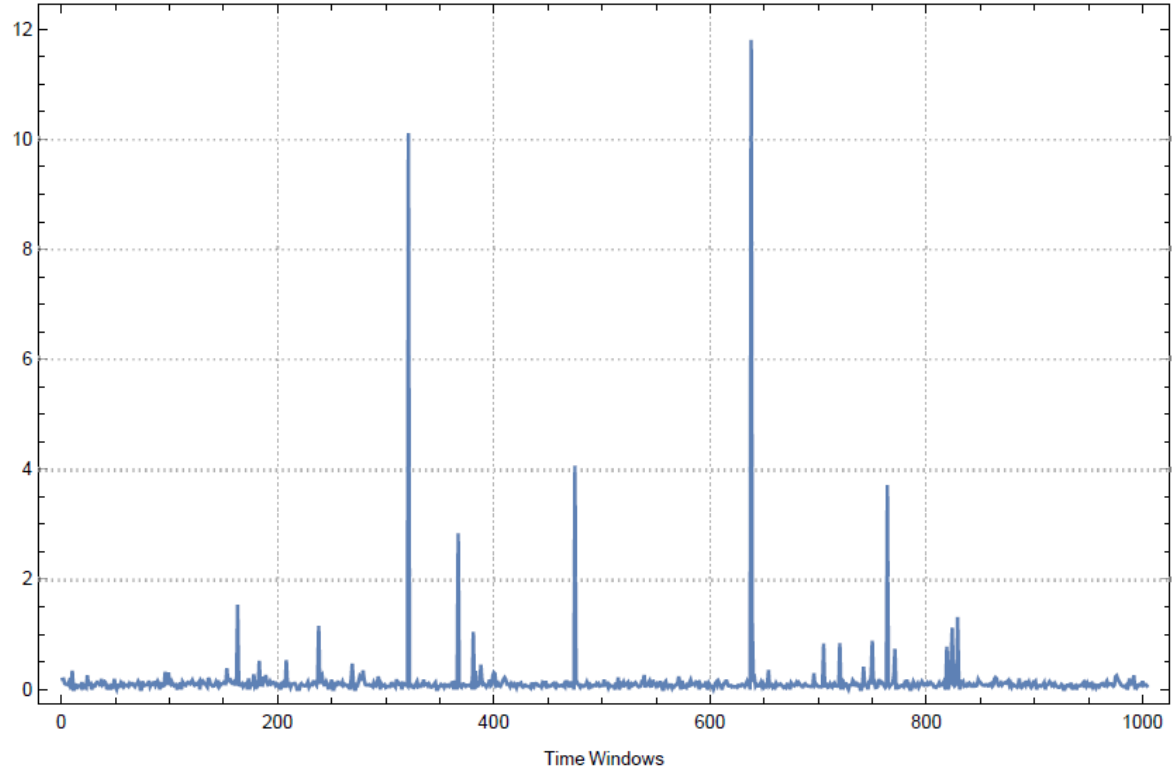
for Nasdaq-100 using TMFG T